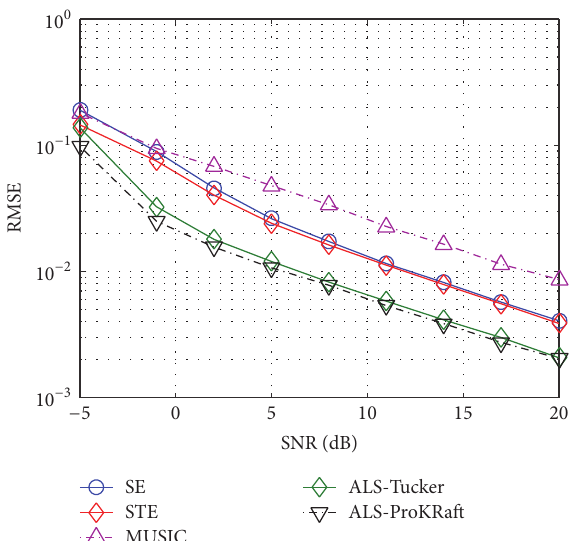
Figure 2: Total RMSE versus SNR for 𝑁 = 64 sensors, 𝐾 = 10 samples, and DoAs: {30 ∘ ,55 ∘ } and {45 ∘ , 60 ∘ } for Hadamard sequen- ces.